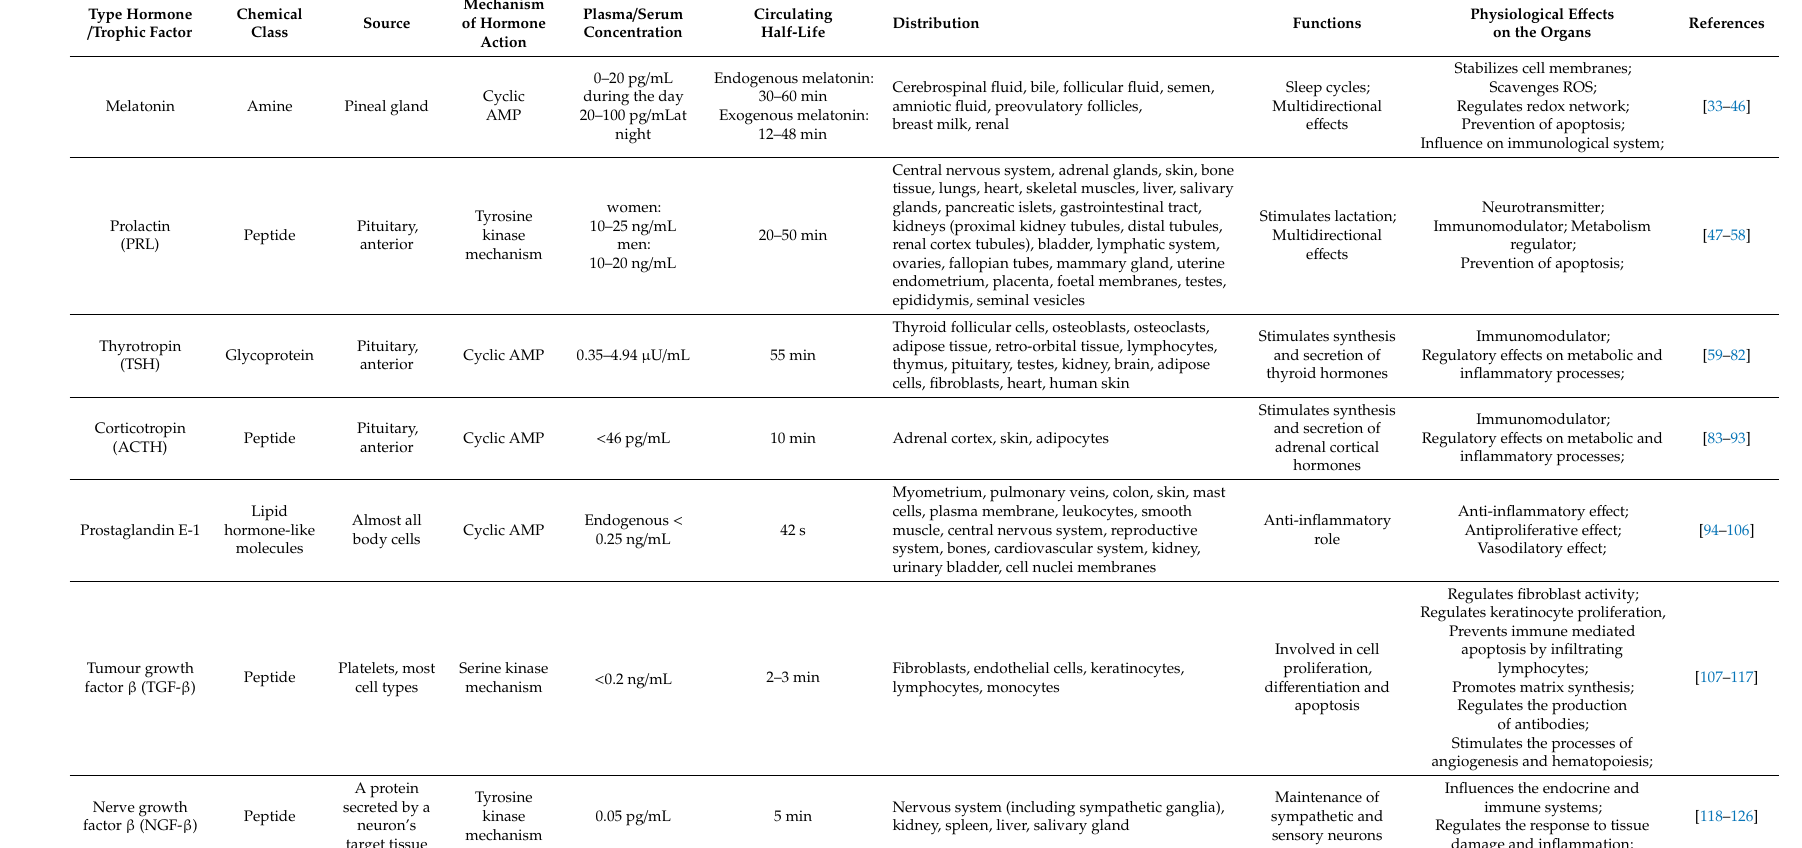
Table 2. The e ff ect of hormones and trophic factors on quality of